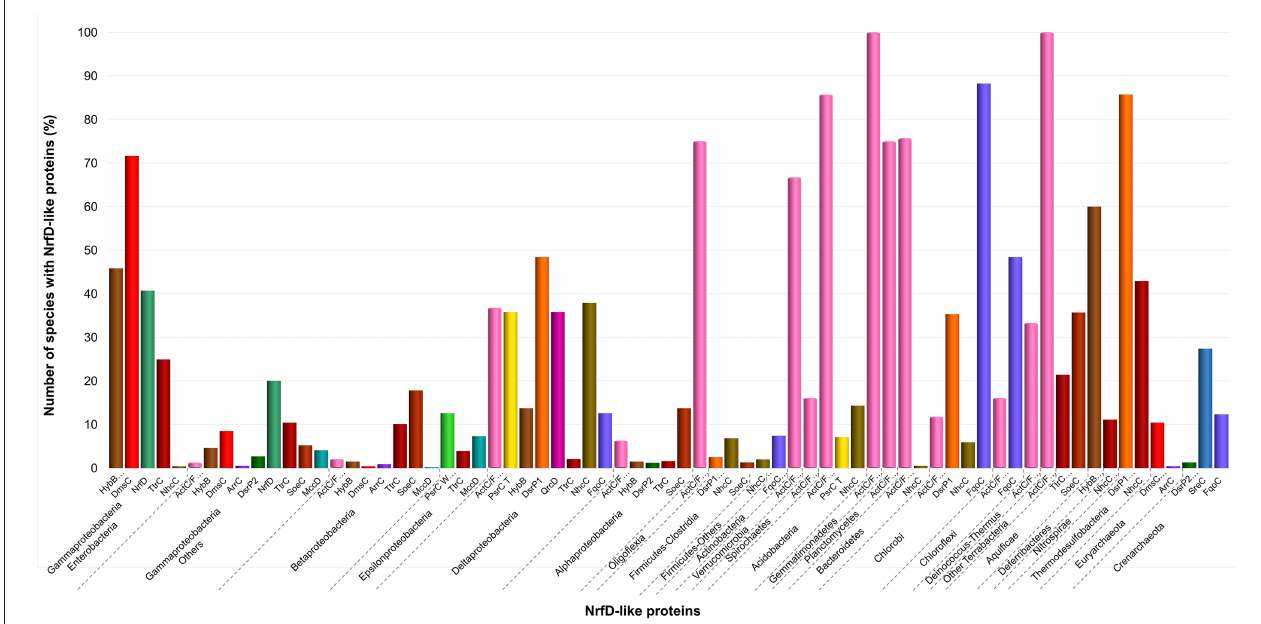
FIGURE 5 | Distribution of NrfD-like subunits in Prokaryotes. The diagram indicates the percentage of the species within each phylum containing at least one gene encoding a NrfD-like subunit. The color code is indicated in the figure.